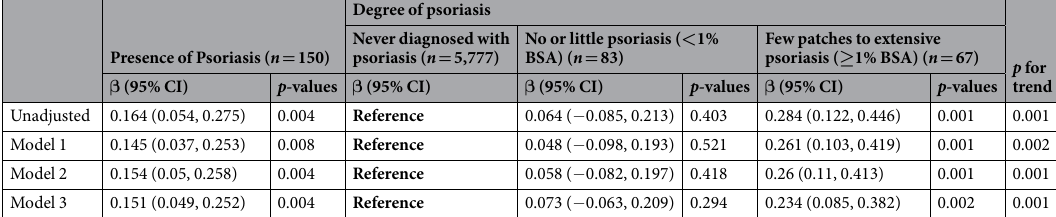
Table 2. Regression coefficients of presence and degree of psoriasis with blood cadmium. Adjusted covariates: Model 1 = age, gender, race/ethnicity, family income, education level. Model 2 = Model 1 + (hypertension, coronary heart disease, arthritis, cancer) + (Body mass index, waist circumference, alcohol consumption, former smoker, smoking dose). Model 3 = Model 2 + (white blood cell count, C-reactive protein, blood lead, blood mercury). CI, confidence interval.